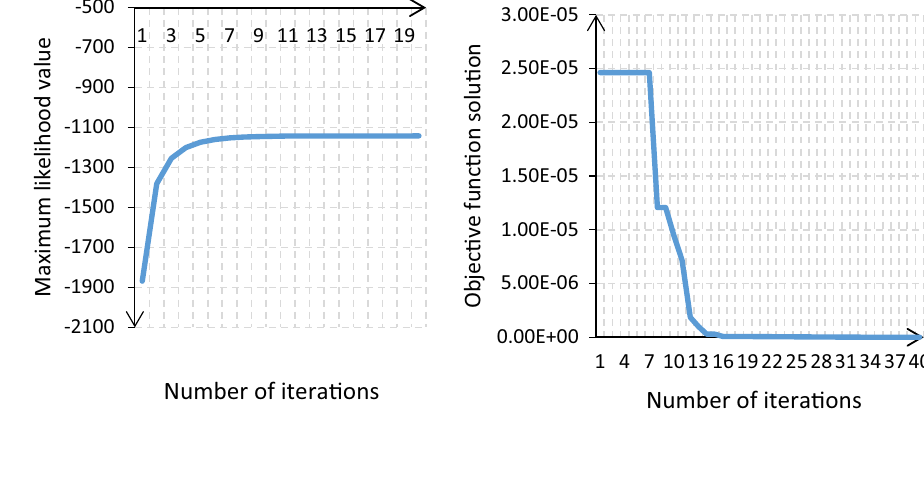
Number of itera(cid:2)ons